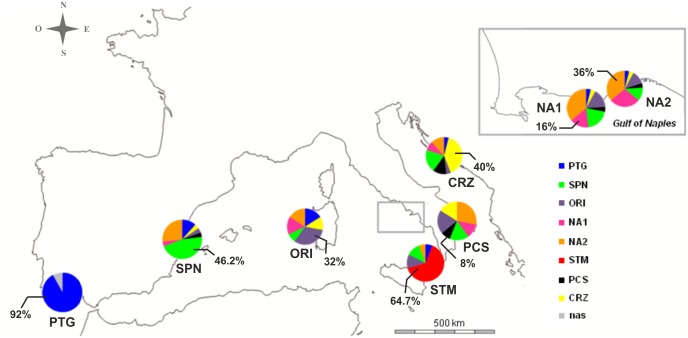
GENECLASS2 assignment test.In the pie graphs, each value indicates the percentage of individuals correctly assigned to the source sampling locality. nas indicates individuals that were not unambiguously assigned. See Table 1 for abbreviations.